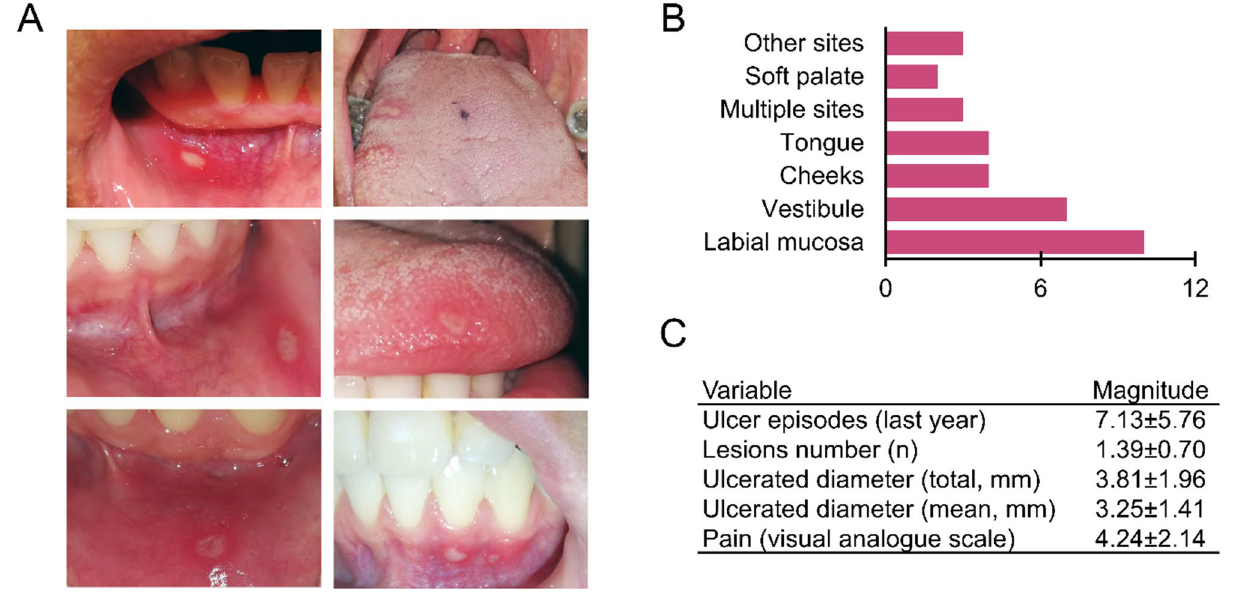
Figure 1. Clinical manifestations of recurrent aphthous stomatitis. ( A ) Representative images of ulcers. Lesions were ovoid with an erythematous halo. ( B ) Anatomical sites where lesions occurred. The most affected regions were labial mucosa, vestibule, and cheeks. (C ) Clinical history associated with ulcers. Lesions were smaller than 5 mm accompanied by moderate